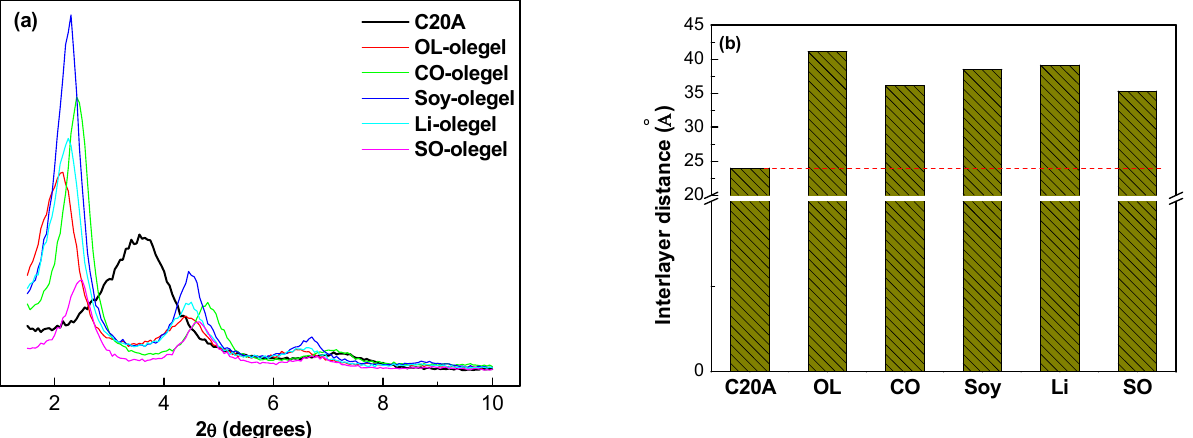
Figure 6. ( a ) TGA/DTG thermograms for pure C20A nanoclay, olive, castor, soybean, linseed and sunflower oils; ( b ) TGA/DTG thermograms for the oleogels formulated with different vegetable oils. X-ray diffraction (XRD) was used to determine the degree of interaction and the ex-